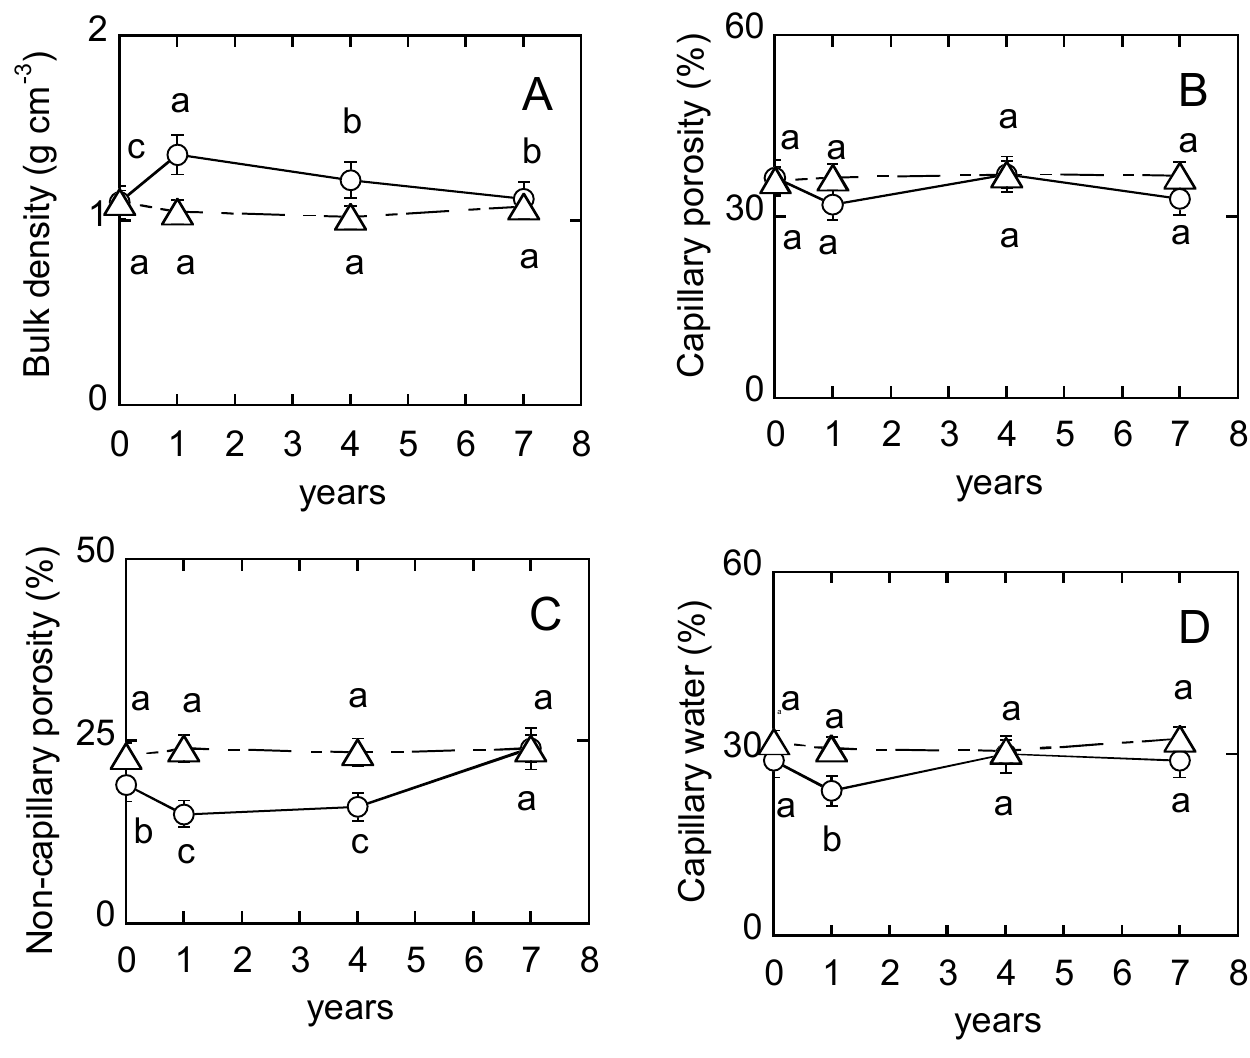
Figure 1. Soil physical properties along a wildfire-induced time span; A , bulk density; B , capillary porosity; C , non-capillary porosity; D , capillary water; each point represents N = 24 with the standard error of the mean indicated; ○ , burned soil; ∆ , unburned soil; standard errors are shown by vertical